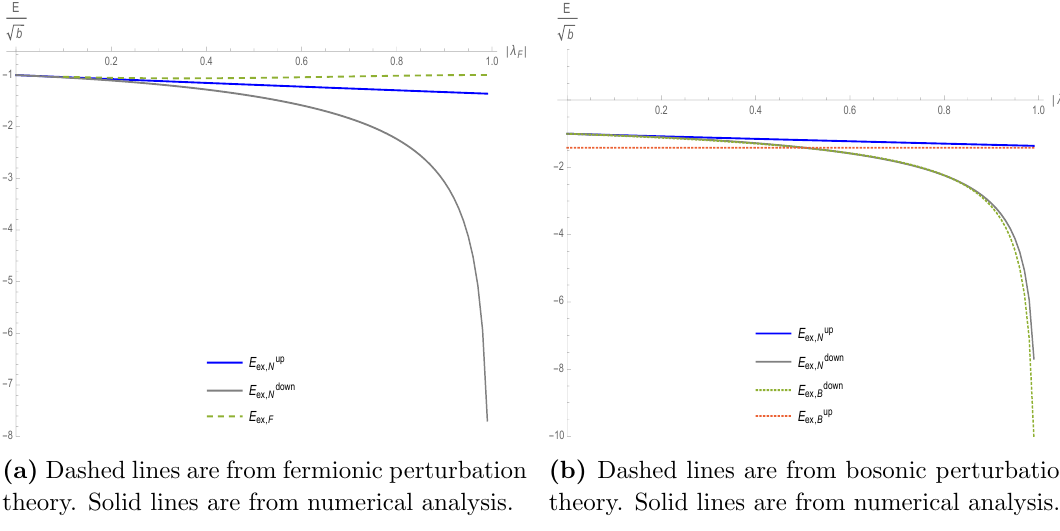
(b) Dashed lines are from bosonic perturbation theory. Solid lines are from numerical analysis.